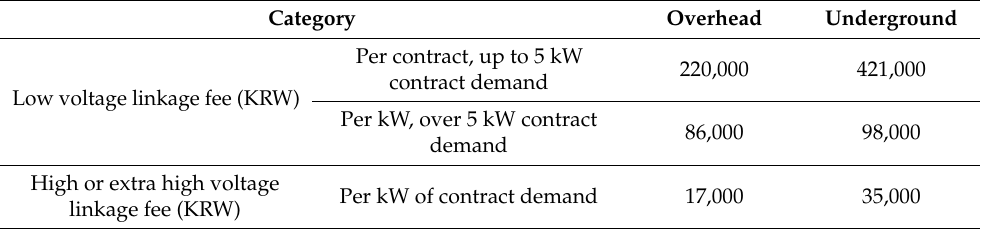
Table 4. Basic infrastructure linkage fee.